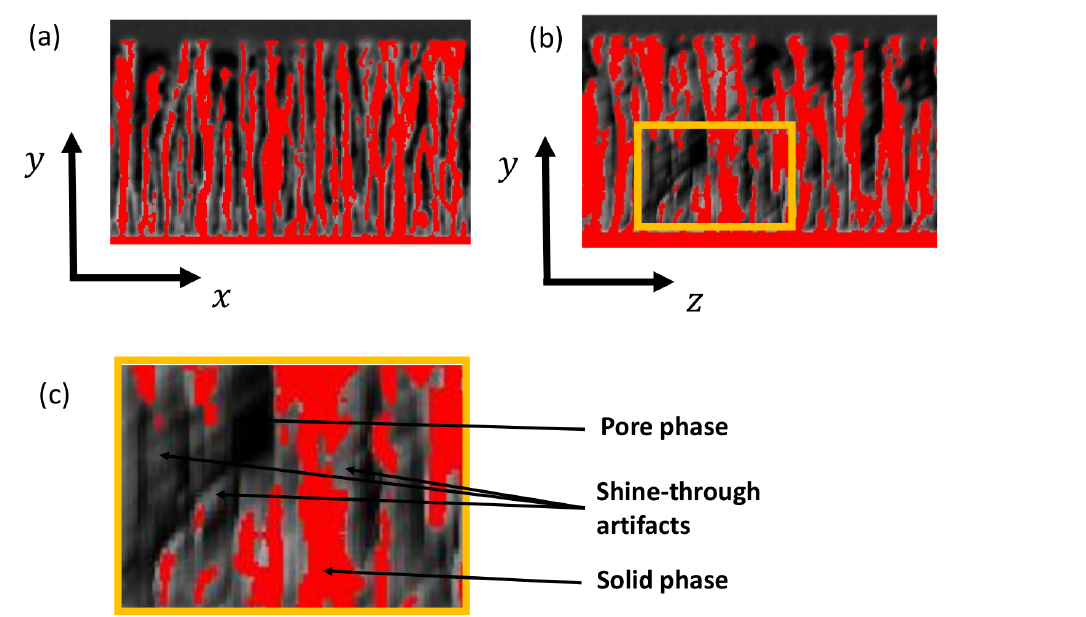
Figure 6. Reconstruction result of the Ta85 sample shown as a red overlay on the gray value slices: (a) xy direction, (b) yz direction, and (c) a close-up of the yz direction.